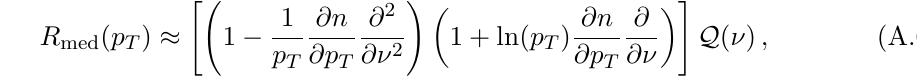
Figure 9 . Ratio of the truncated expansion of R med from eq. (A.2) to the exact value for the soft BDMPS-Z model from eq. (A.1) (left), and the same with the full quenching weight from eq.